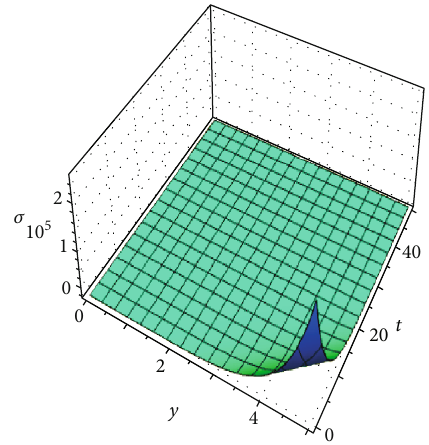
Figure 7: The spatiotemporal entropy pro fi le S .